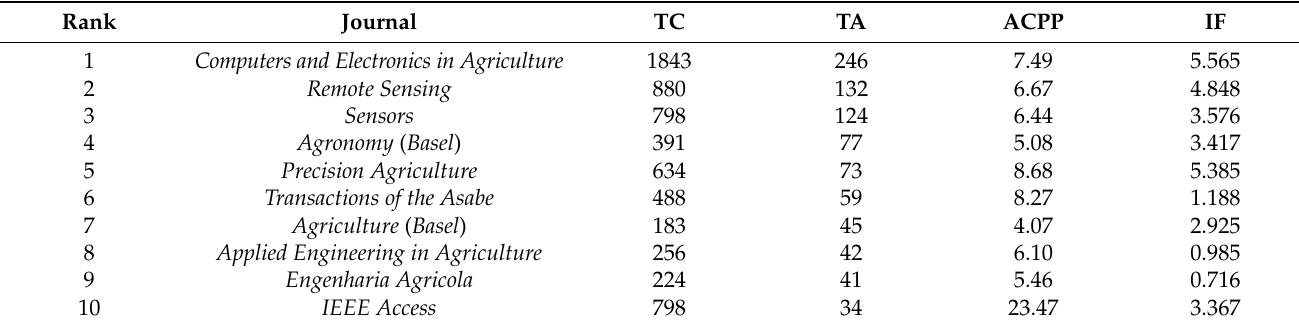
Table 5. Journal impact analysis.